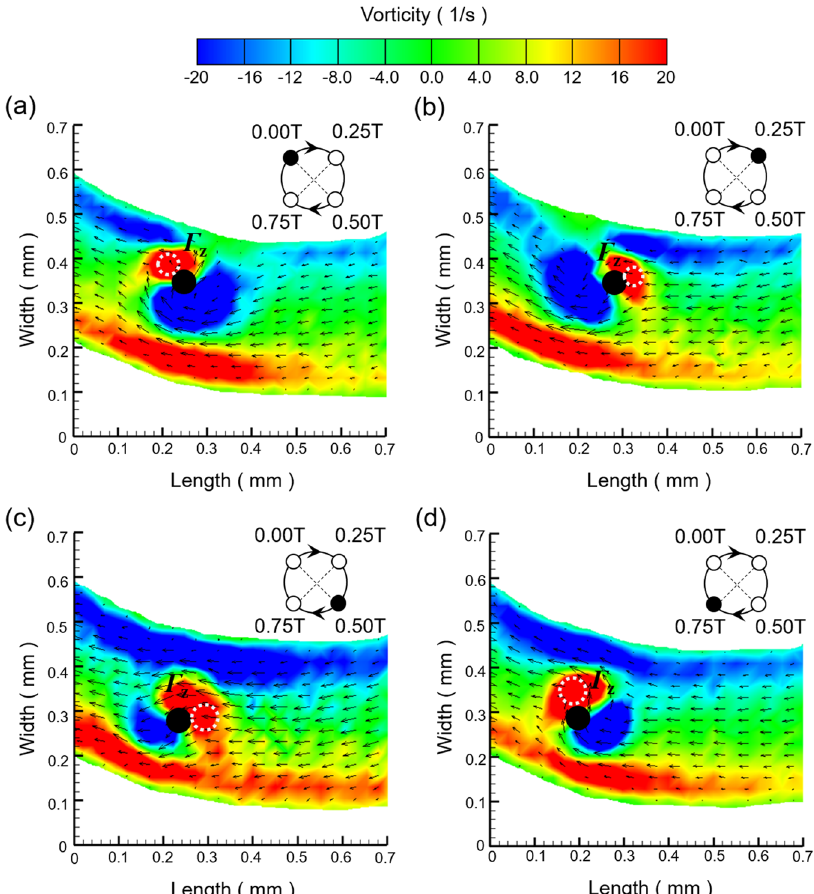
Figure 5. ( a – d ) Time-ensembled vorticity contour superimposed with mean velocity vectors at four different time points in a rotational cycle of artificial cilia for Mode III. The black circle represents the physical presence of an artificial cilium. The white dashed circle refers to the area calculated for circulation